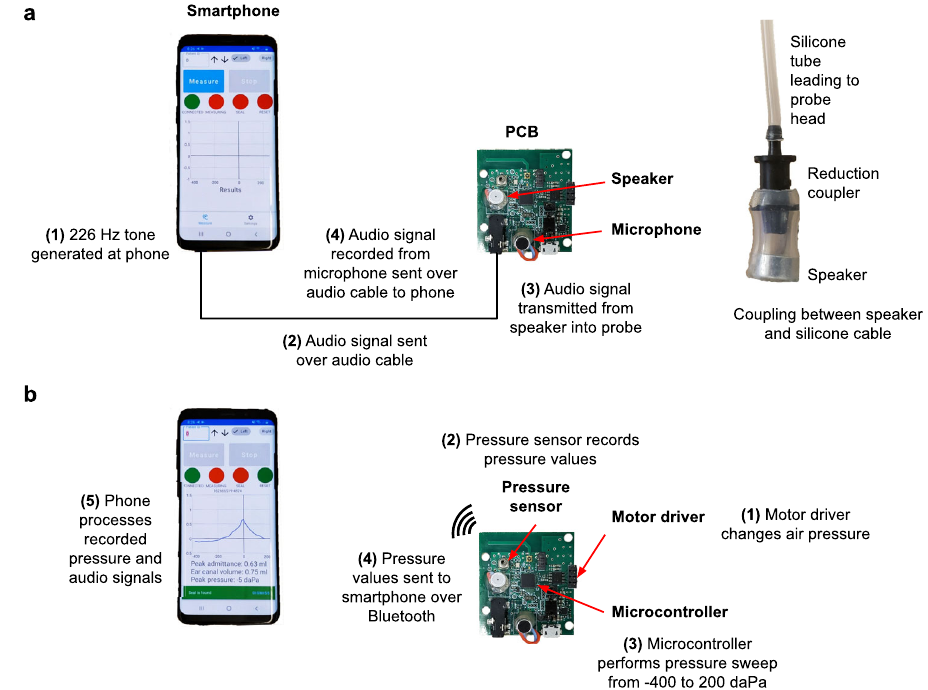
Fig. 2 Working principle of our smartphone-based tympanometry device. a Audio signal generation and reception. b Pressure sweeping, sensing and communications.